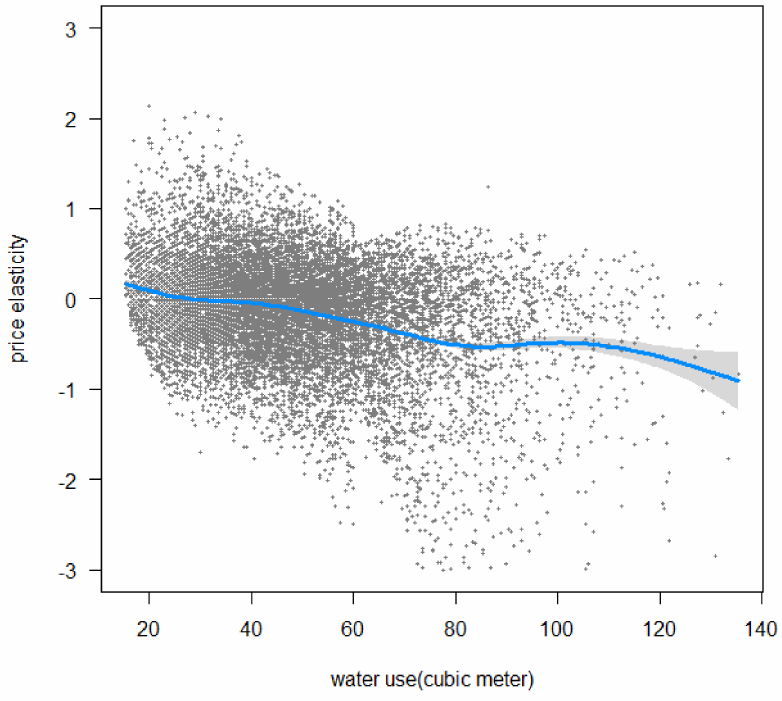
Figure 2. Residential water use before the tariff revision versus price elasticity in June. The shade shows 95% significant